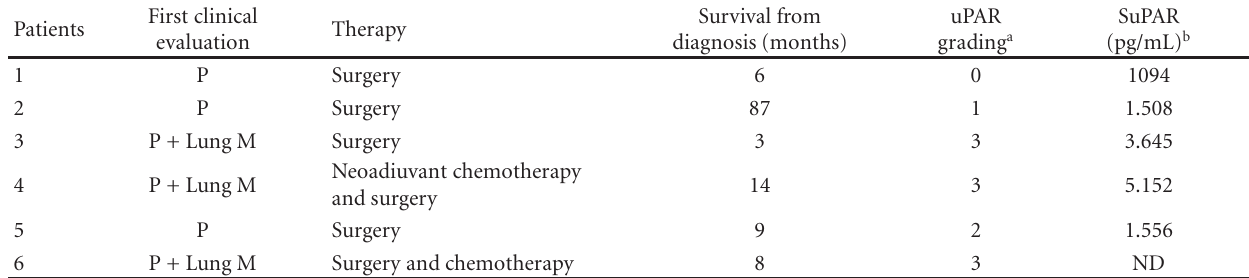
Table 2: Clinicopathological parameters and uPAR levels in tumour tissues and in plasma of patients with chondrosarcoma.